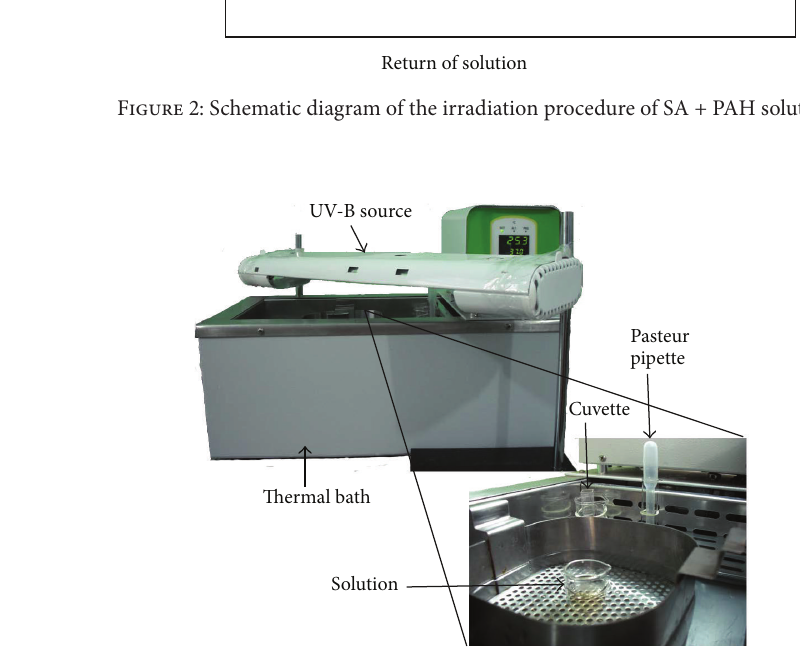
Figure 3: Experimental setup used to control the temperature of the